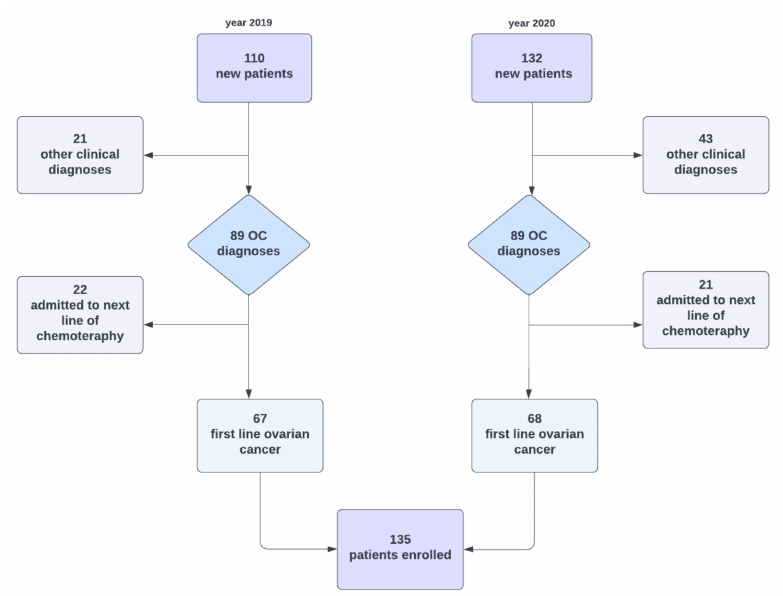
Figure 1. Flow-chart. OC—ovarian cancer. The inclusion criteria: (i) the histopathological confirmation of ovarian cancer based on surgery with laparotomy, laparoscopy or biopsy, (ii) over 18 years of age, (iii) not pregnant and (iv) written consent to the proposed treatment, including both surgical treatment and subsequent chemotherapy.